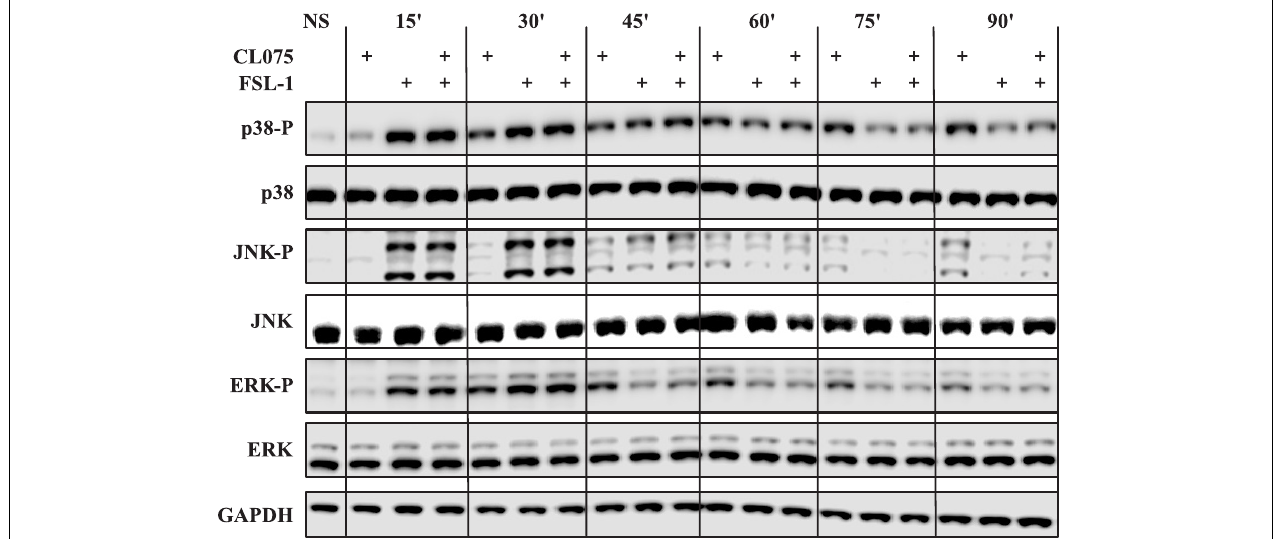
FIGURE 3 | Co-stimulation affects the MAP kinase phosphorylation cascades. Human primary monocytes (representative donor shown) were stimulated as earlier described and protein lysates were collected in 15-min intervals after stimulation and evaluated for the phosphorylation status of the MAP kinases p38, ERK1/2 and JNK, as phosphorylation of these kinases are indicative of activation. TLR2 stimulation shows a rapid and strong phosphorylation of all three kinases which is also evident for co-stimulation. The kinases are then de-phosphorylated after about 45 min. TLR8 shows a slower but lasting phosphorylation pattern of these kinases. Here co-stimulation is dominated by the de-phosphorylation induced by